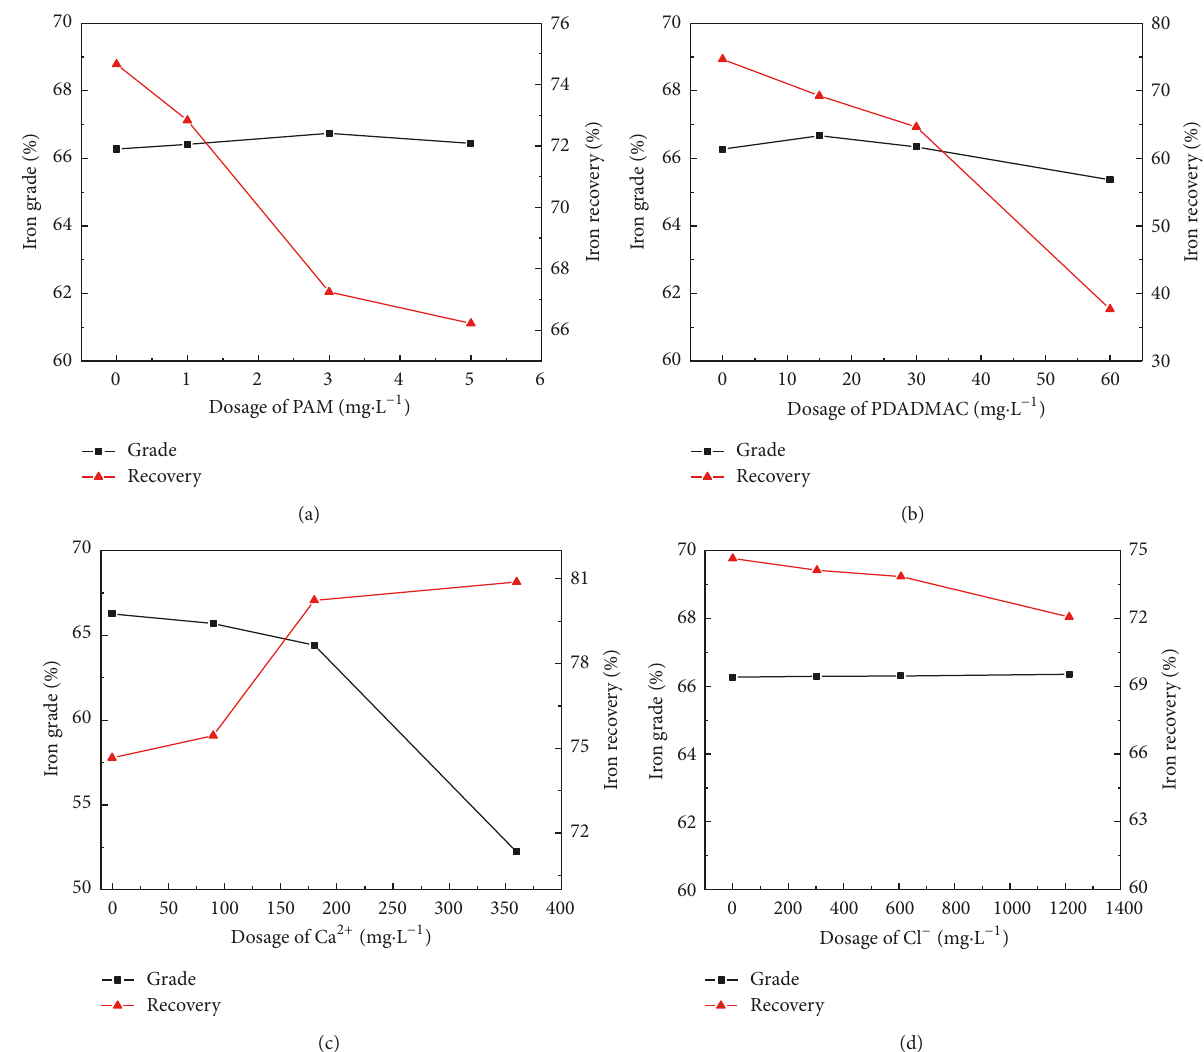
Figure 3: Effects of PAM (a), PDADMAC (b), Ca 2+ (c), and Cl − (d) on flotation